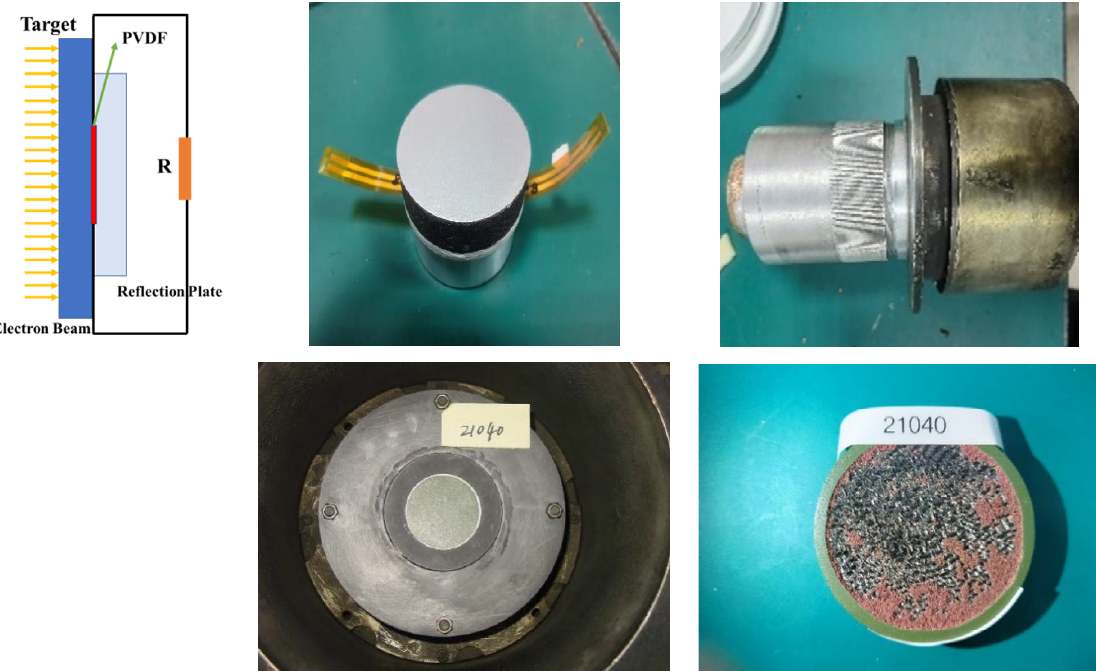
Figure 3. Photos of PVDF sensor and sample before and after experiment No. 21040.